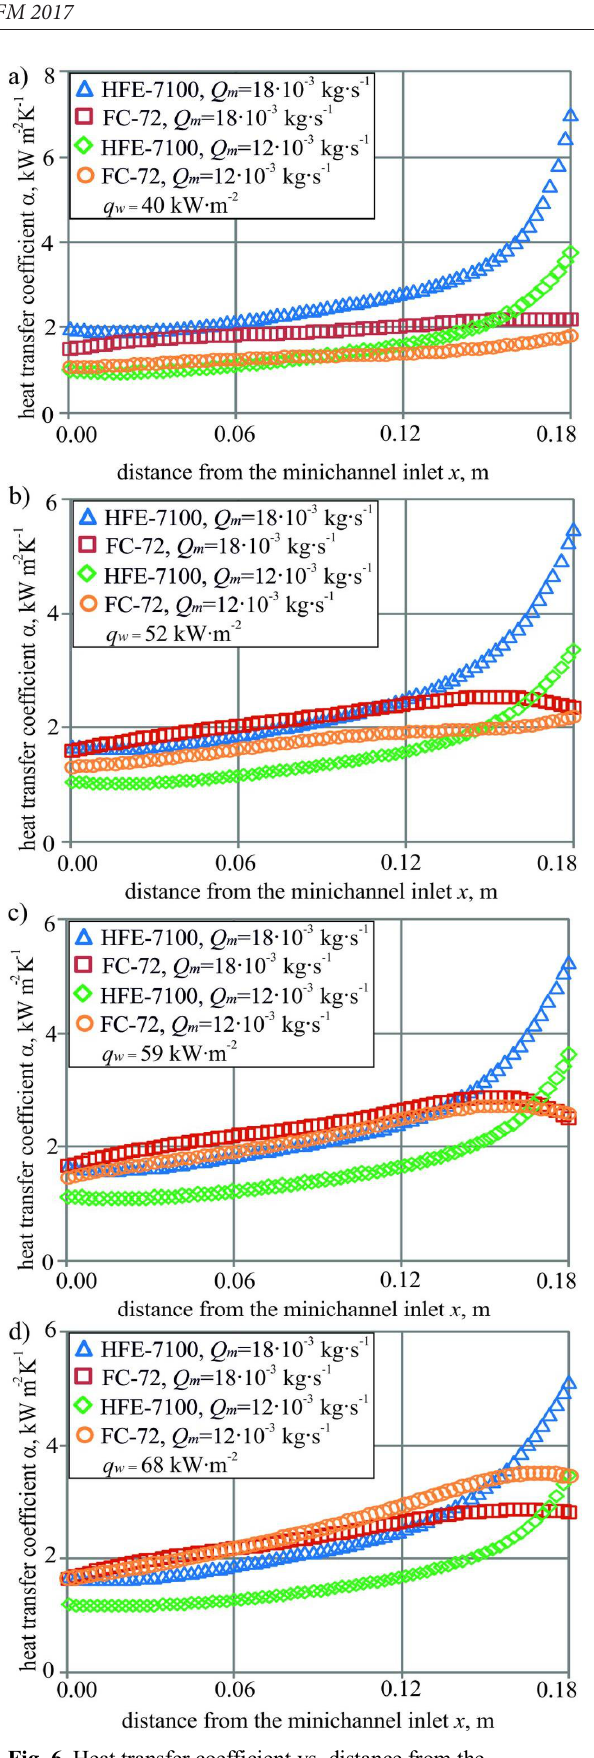
Fig. 6. Heat transfer coefficient vs. distance from the minichannel length obtained for the subcooled boiling region, experimental parameters shown in Table 1.